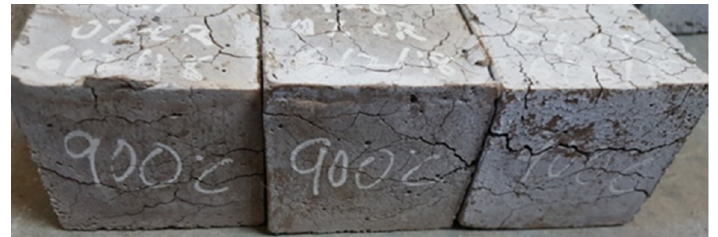
Figure 5. CR ‐ ECC with 0% CR at 900 °C.